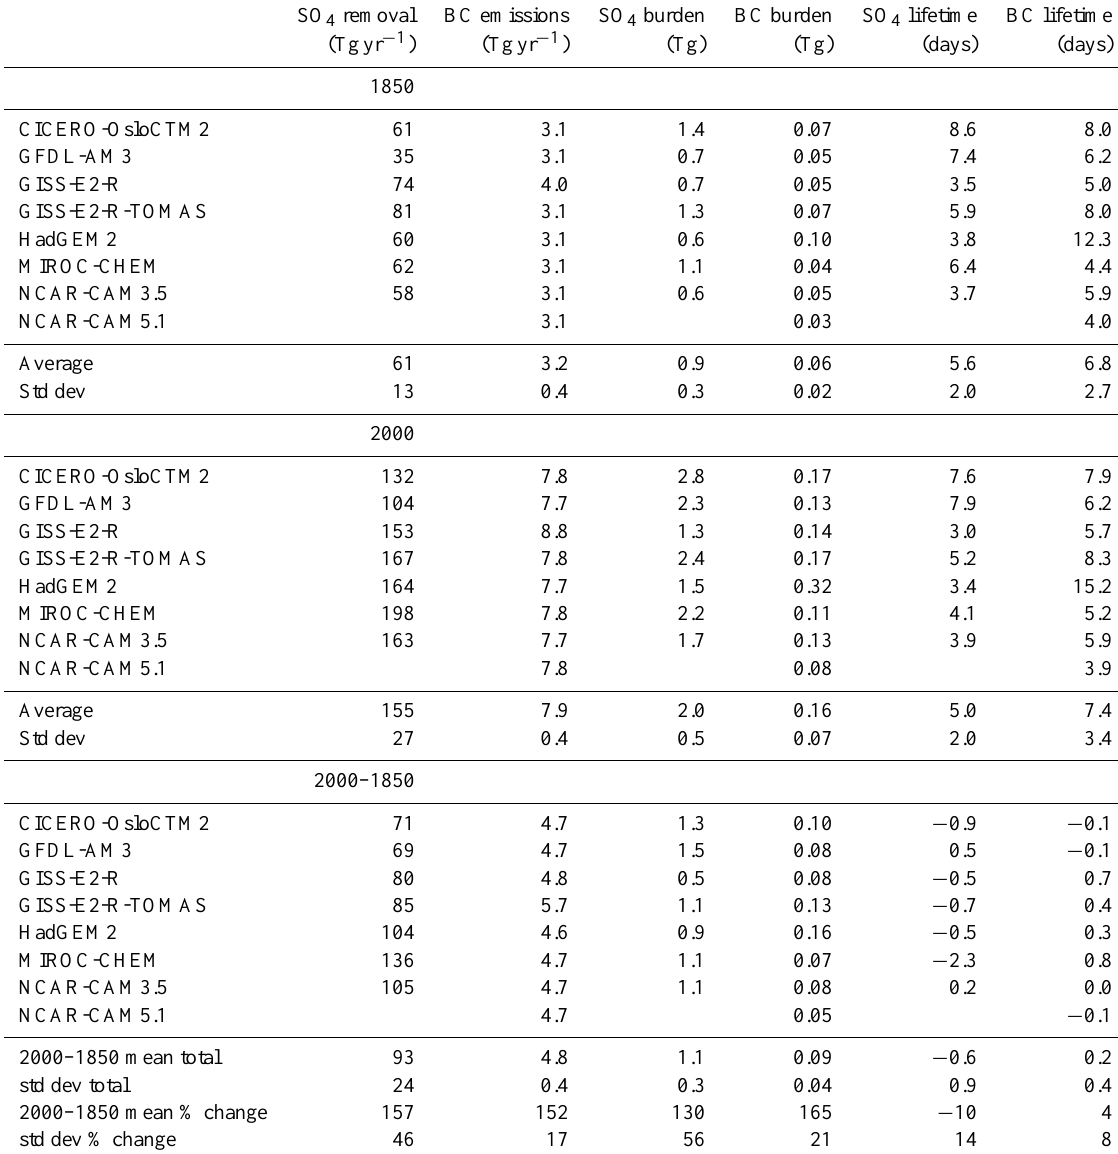
Table F1. Emissions or removal and burdens for sulfate and